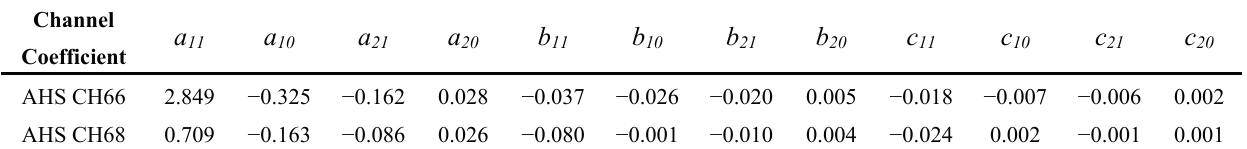
Table 1. Fitting coefficients for the direct solar radiance estimation.